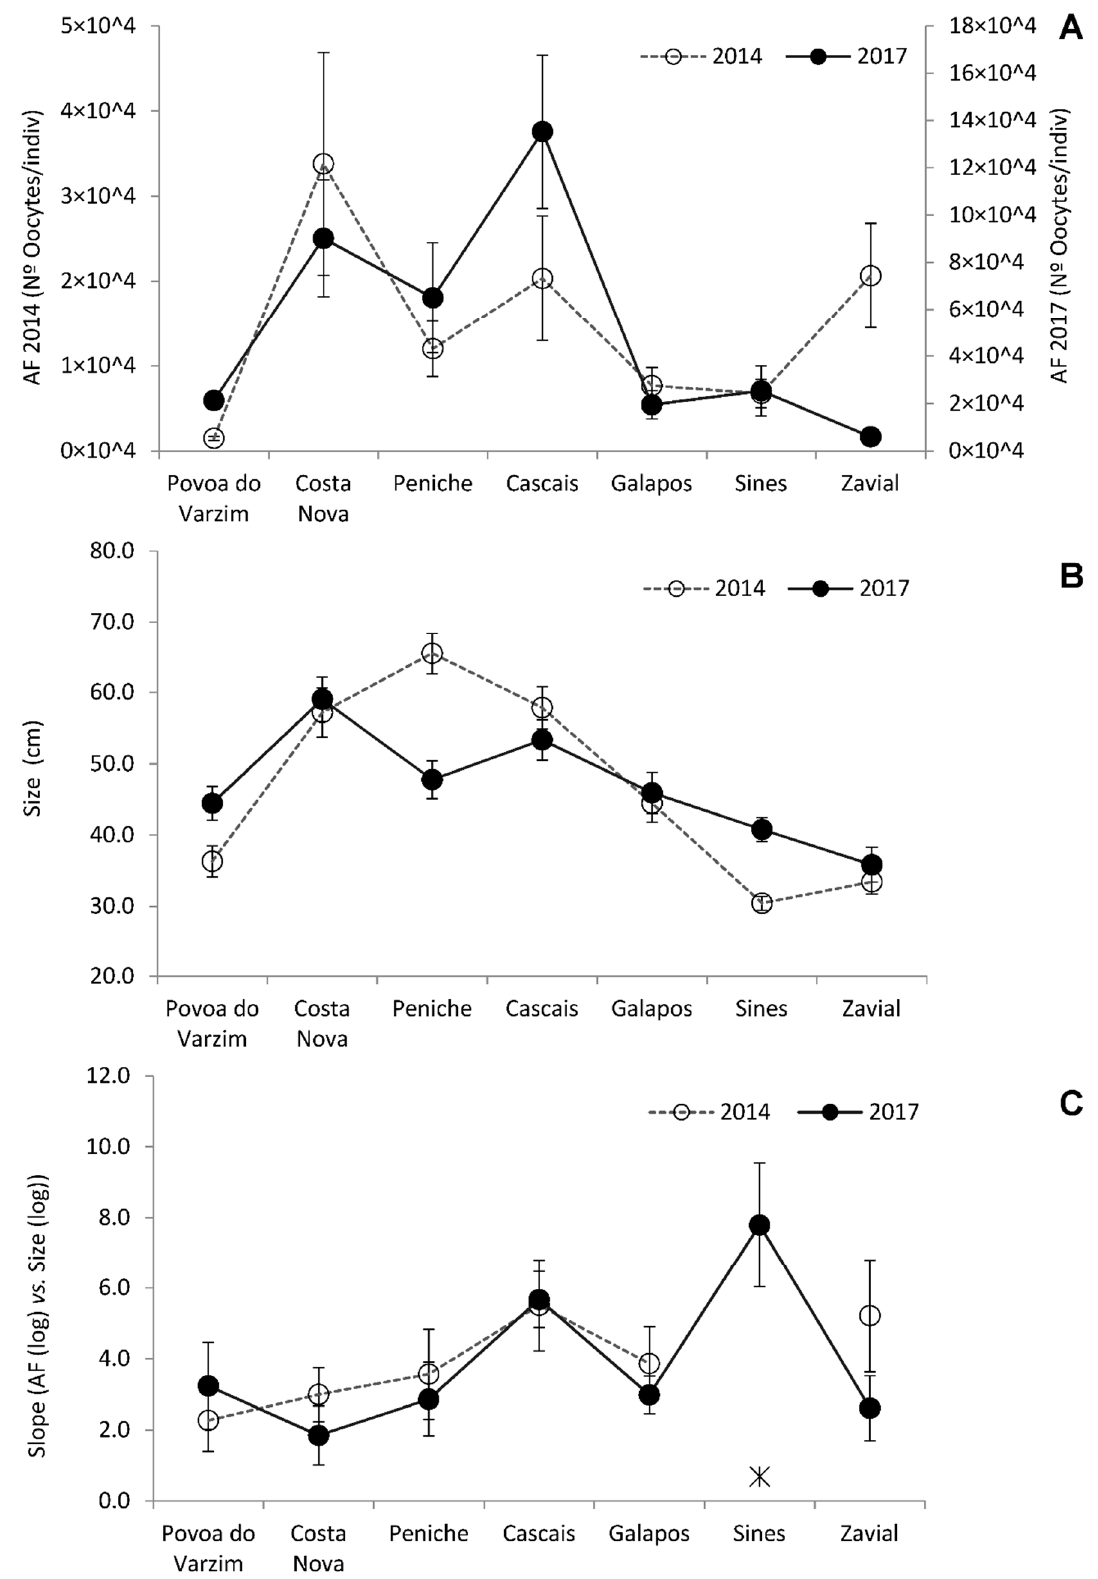
Figure 3. Average and standard error of ( A ) absolute fecundity (AF, n ◦ . oocytes per individual), ( B ) Size (mm) and ( C ) Coefficients Slopes of Analysis of Covariance (ANCOVA) between AF (logarithm-transformed) and Size (log), significant values ( p < 0.05), except to Sines. Data of the different locations along the Portuguese coastline, from North (left) to South (right), during the years 2014 and